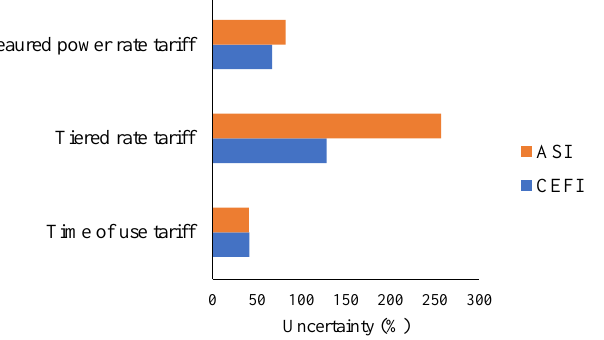
Figure 14. The uncertainties related to the CEFIs and ASIs for the three business models of dynamic pricing